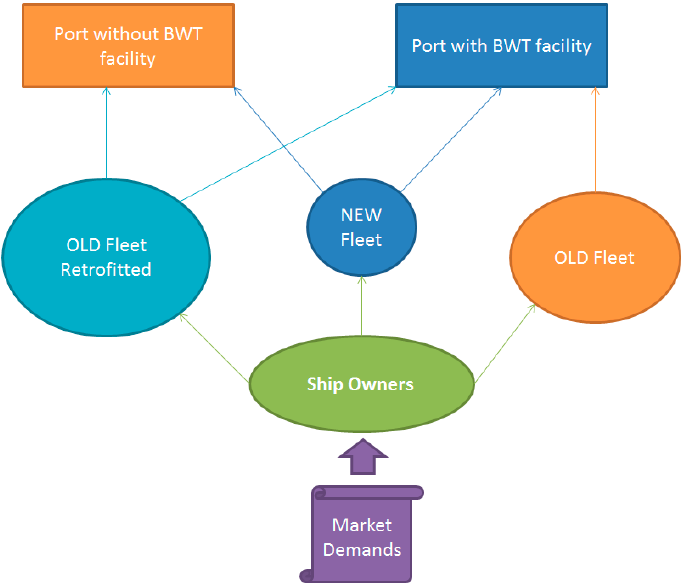
Figure 2. Diagram of the port’s strategy.